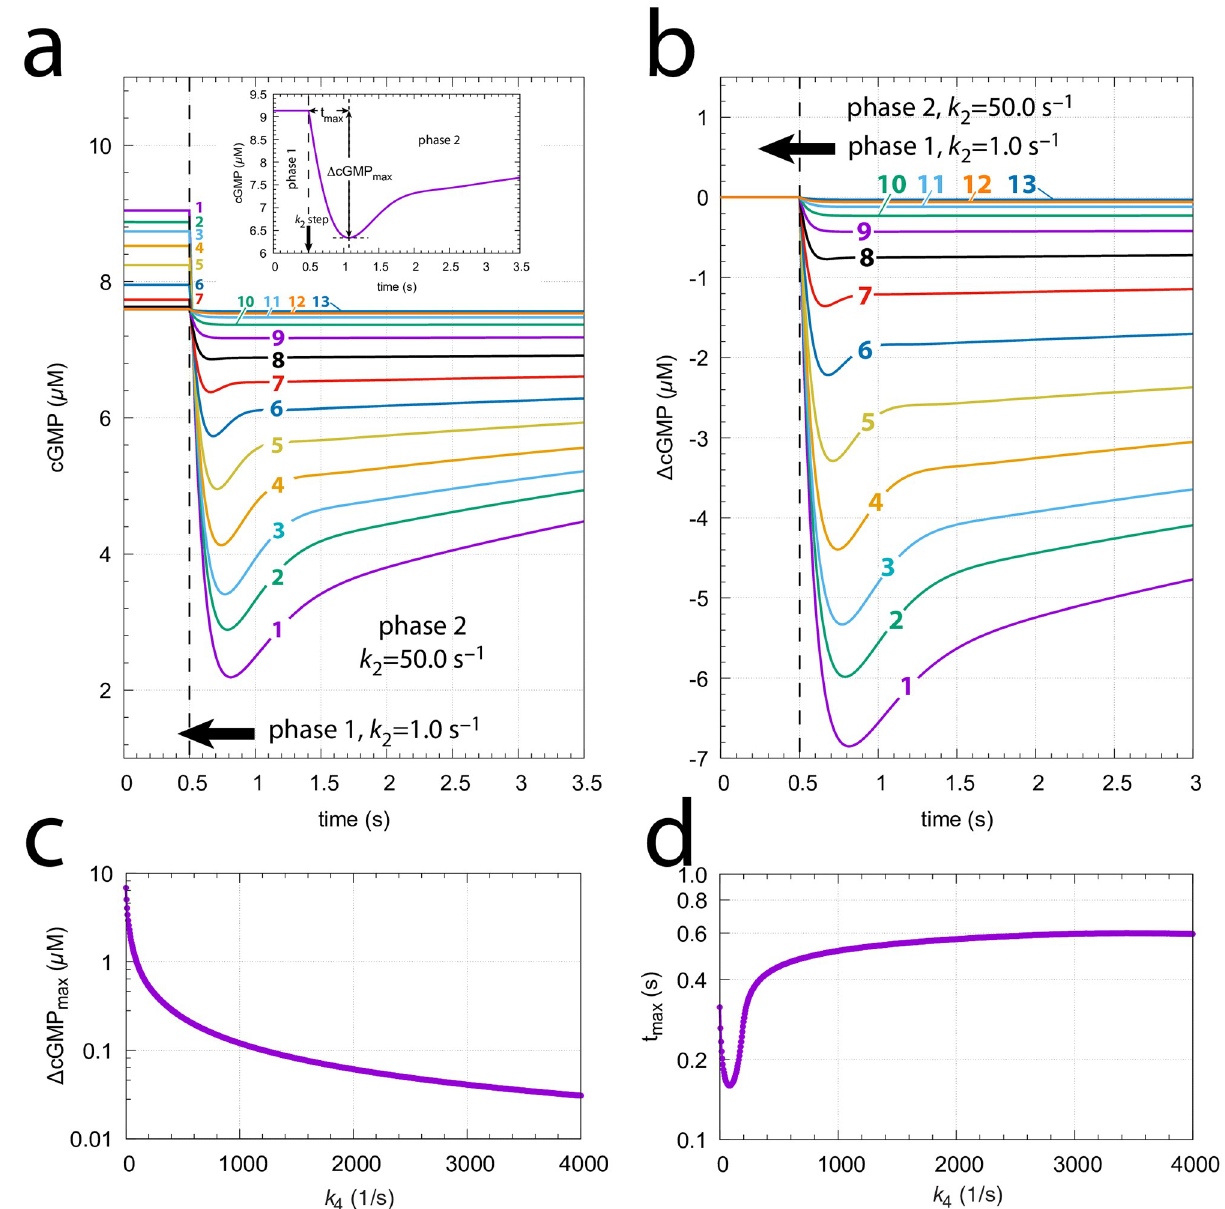
Fig 16. The model’s response towards k 21 ! 50 s − 1 steps at different backgrounds k 4 . (a) Unscaled cGMP concentrations as a function of time. The steps occur at t =0.5 s. Background k 4 values (s − 1 ): 1 , 0.0; 2 , 2.0; 3 , 4.0; 4 , 8.0; 5 , 16.0; 6 , 32.0; 7 , 64.0; 8 , 128.0; 9 , 256.0; 10 , 512.0; 11 , 1024.0; 12 , 2048.0; 13 , 4096.0. Initial concentrations (in μ M): cGMP 0 =9.04191, Ca 2 þ ¼ 1 : 25717 , K þ ¼ 1 : 25717 ( k 4 =0 s − 1 ); cGMP 0 =8.87243, Ca 2 þ ¼ 1 : 05733 , K þ ¼ 0 0 i ; 0 i ; 0 2 : 36445 ( k 4 =2 s − 1 ); cGMP 0 =8.73490, Ca 2 þ ¼ 9 : 33822 , K þ ¼ 2 : 67717 ( k 4 =4 s − 1 ); cGMP 0 =8.52196, Ca 2 þ ¼ 7 : 79015 , K þ ¼ 3 : 20918 ( k 4 =8 s − 1 ); 0 0 i ; 0 i ; 0 cGMP 0 =8.24168, Ca 2 þ ¼ 6 : 08968 , K þ ¼ 4 : 10531 ( k 4 =16 s − 1 ); cGMP 0 =7.95044, Ca 2 þ ¼ 4 : 40458 , K þ ¼ 5 : 67591 ( k 4 =32 s − 1 ); cGMP 0 =7.73313, 0 0 i ; 0 i ; 0